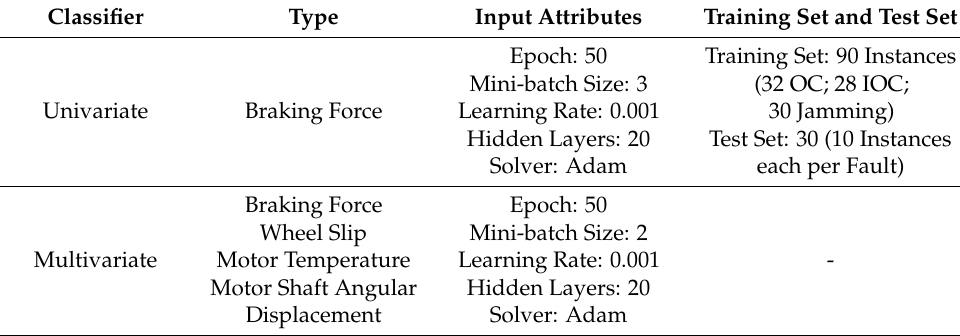
Table 4. LSTM Model